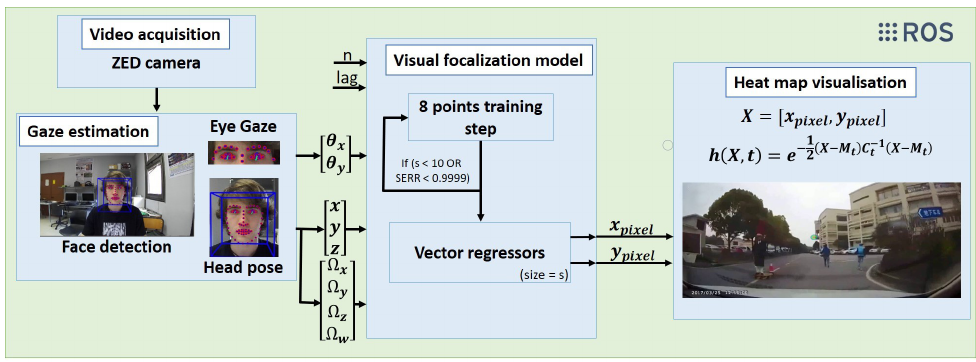
Figure 1. Non-linear calibration